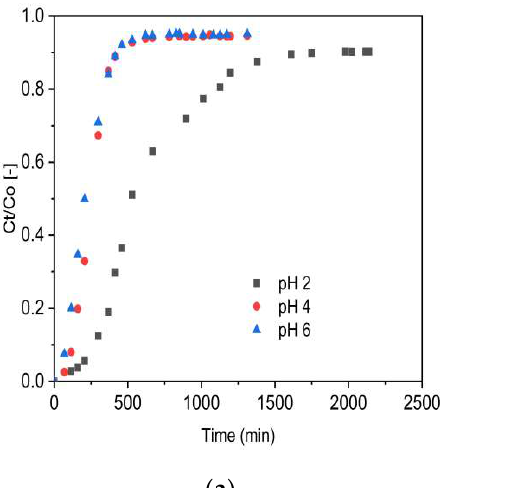
Figure 4. TGA-DTA thermograms of ( a ) VSco and ( b ) ZrOCSc before adsorption experiments.